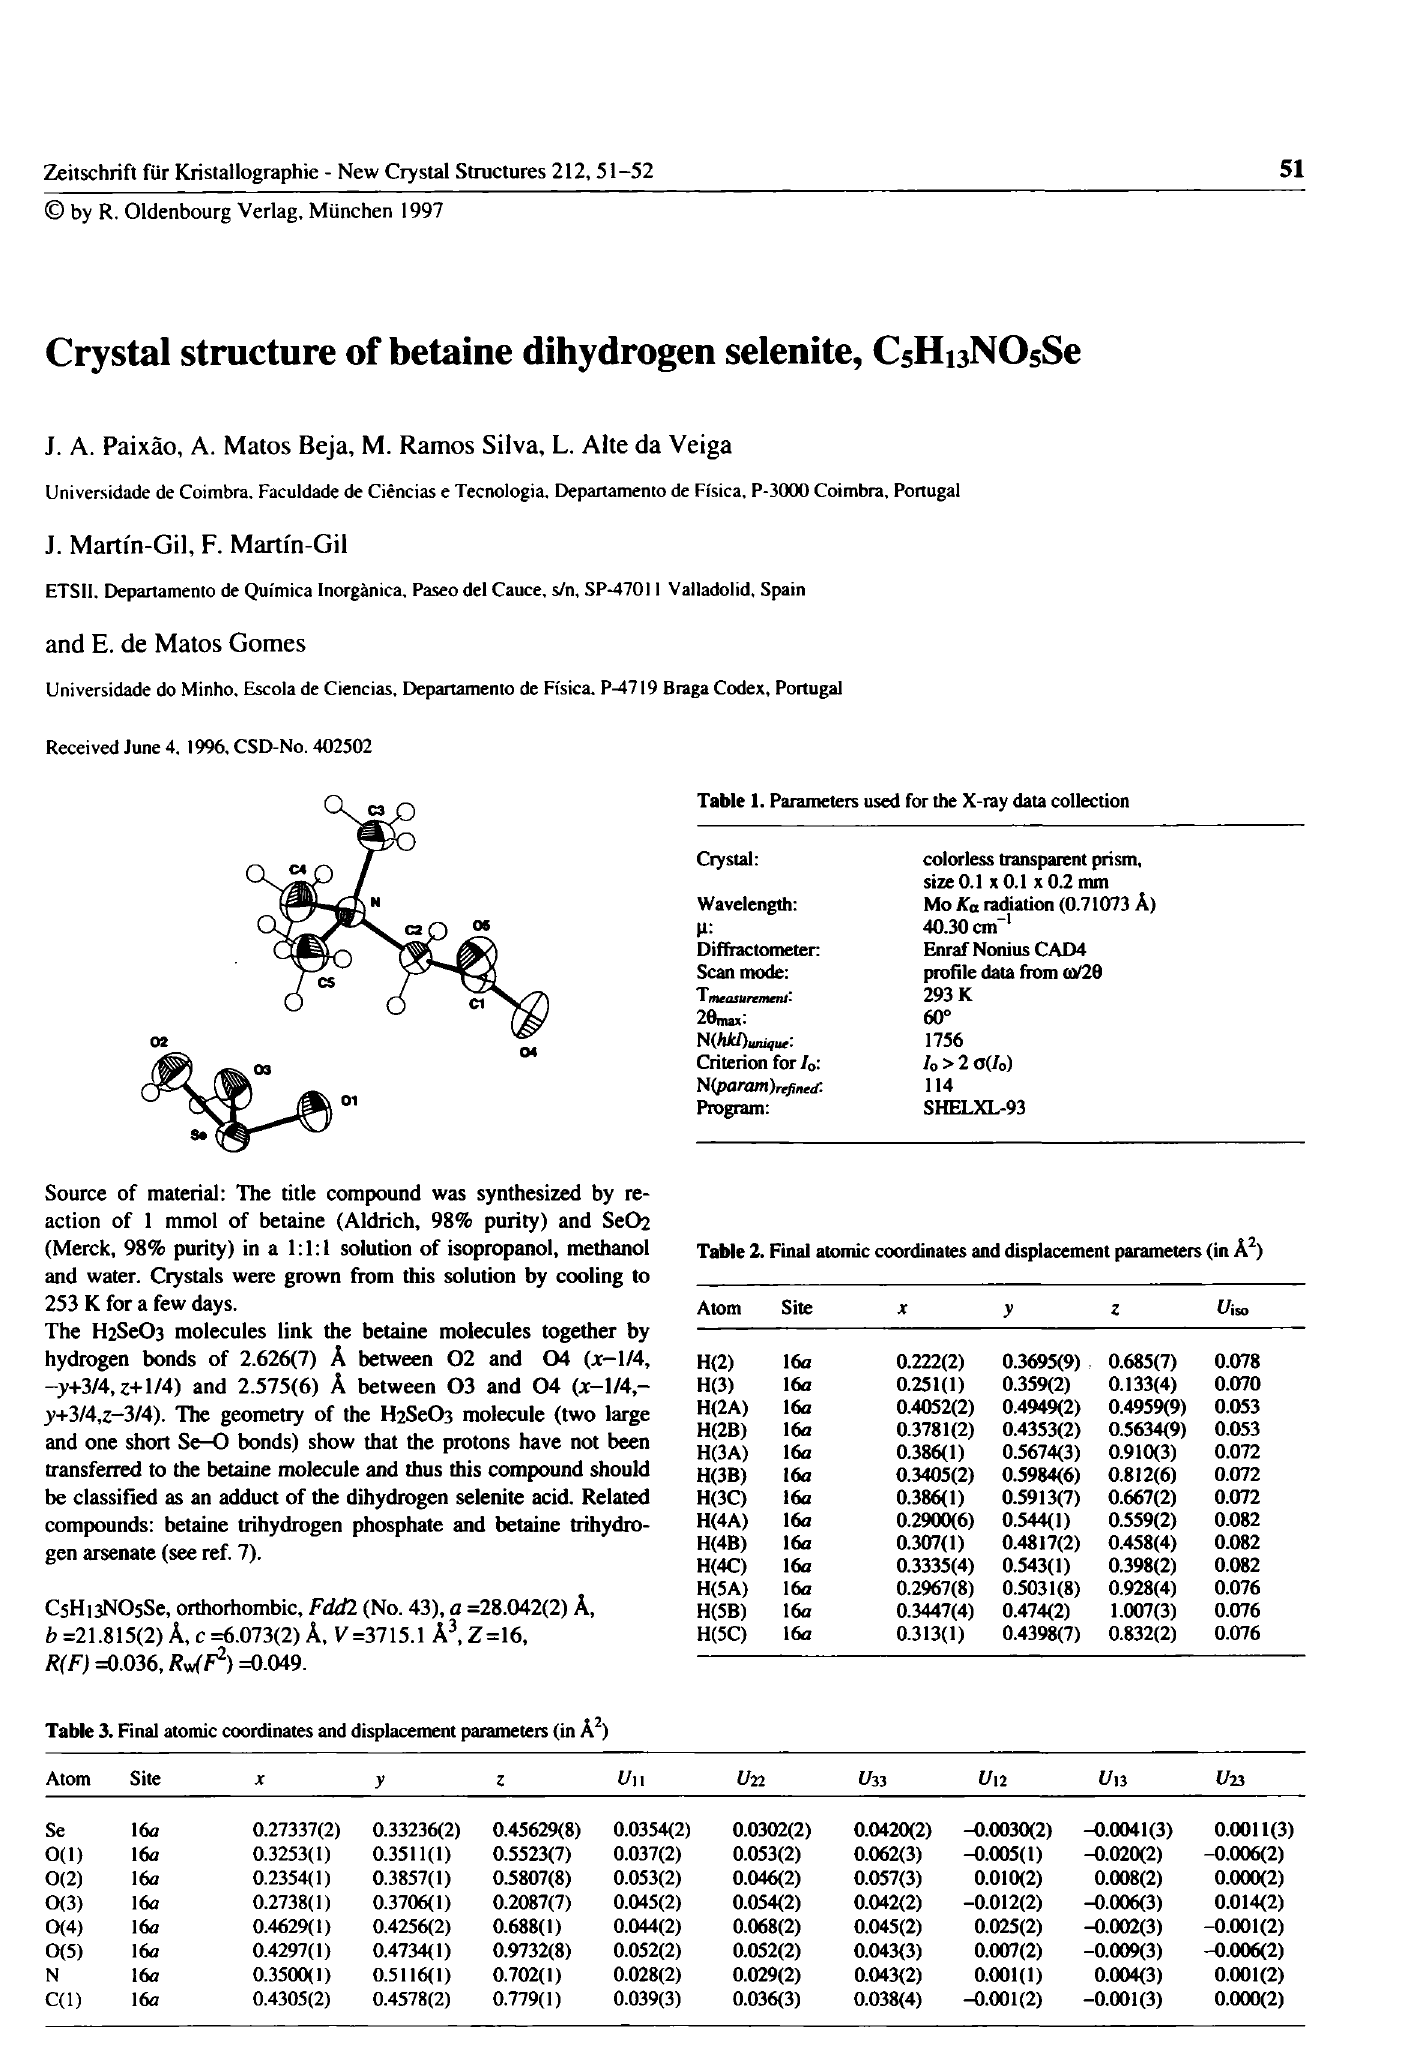
Table 3. Final atomic coordinates and displacement parameters (in Â 2 )